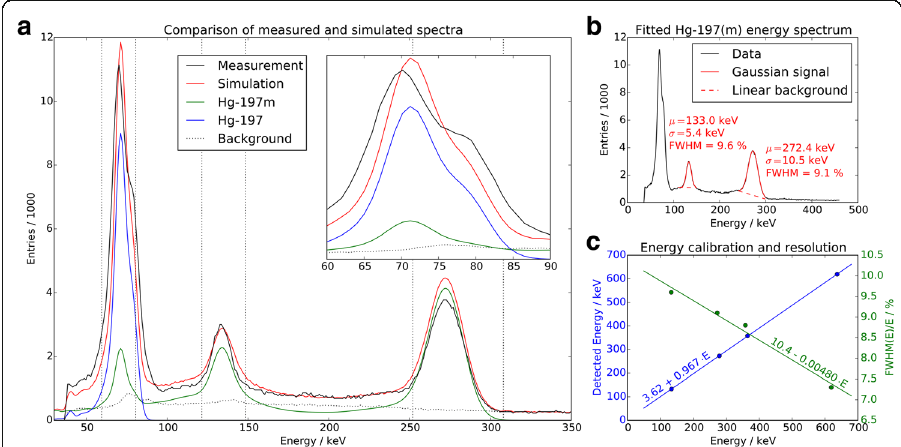
together such that the overall simulated counts match those of the measured spectrum with the normalized background removed.